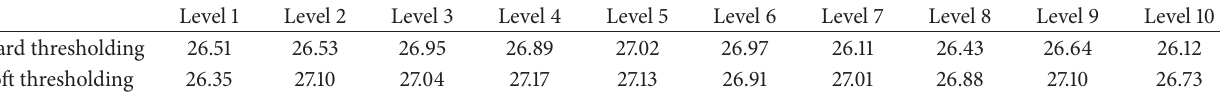
Table 5: The SNR results of rotation speed with hard thresholding and soft thresholding (dB).